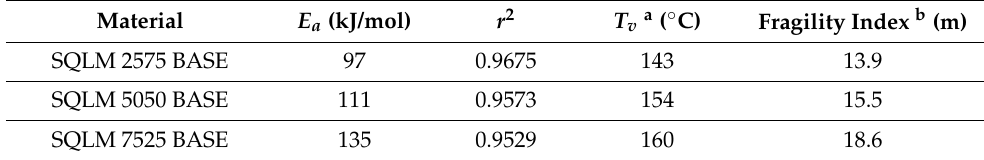
Table 5. Main data extracted from creep experiments of the materials catalyzed by